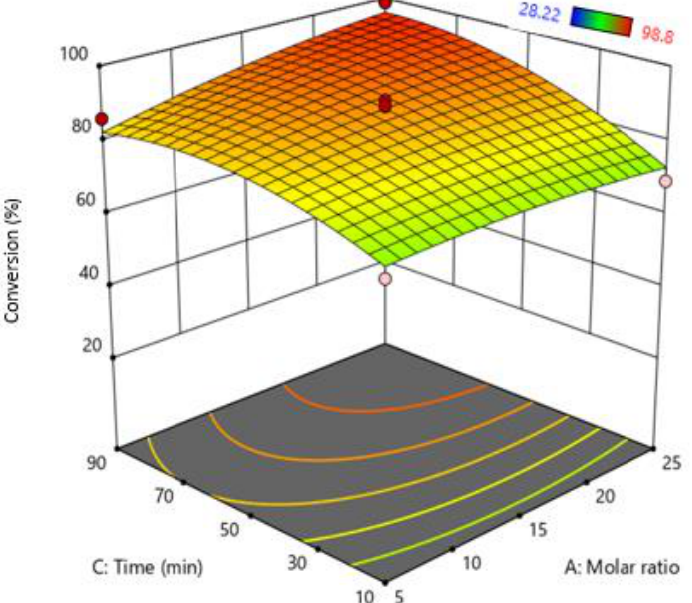
Figure 4. Interactive effect of molar ratio and reaction time .